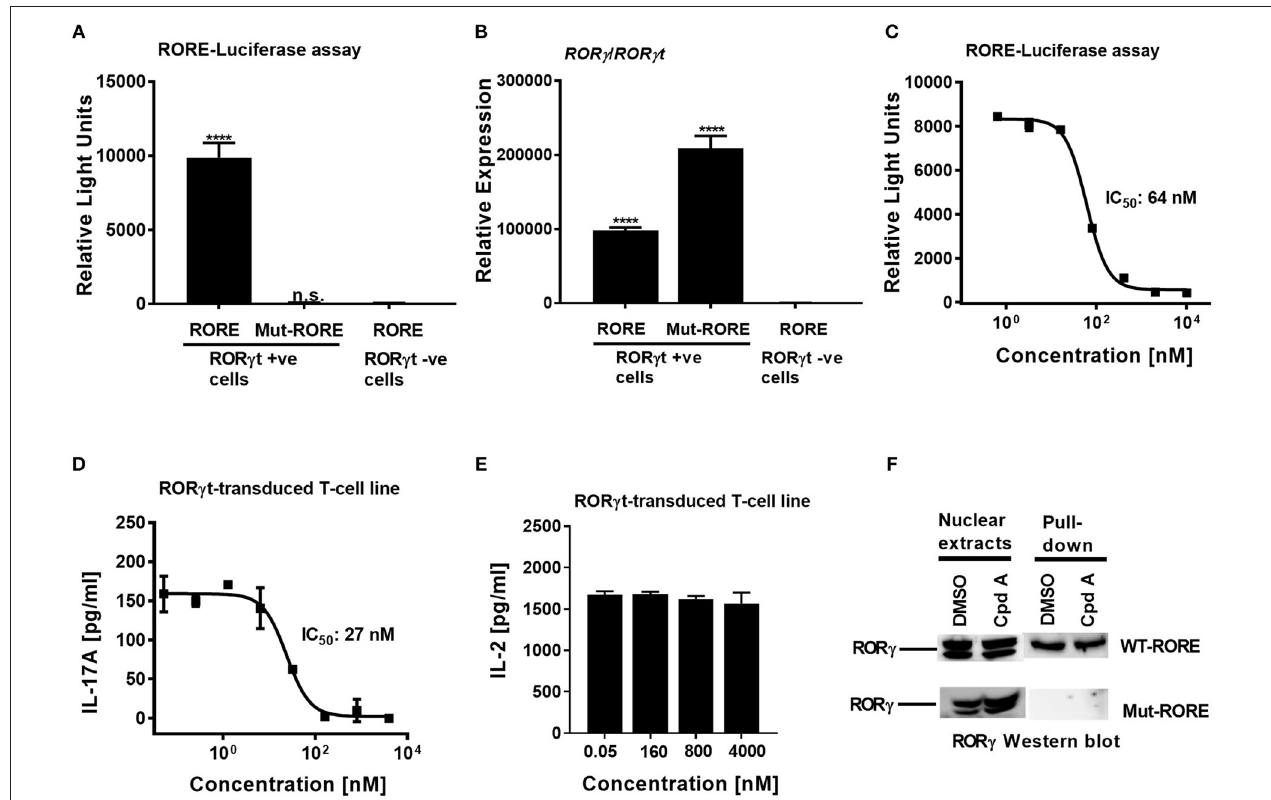
FIGURE 2 | Cpd A potently inhibits transcriptional activity of human ROR γ t in the full-length context in T-cells. (A) Full-length ROR γ t drives wild-type RORE-dependent activation of a reporter gene in HUT78 T-cells expressing ROR γ t, but not in ROR γ t negative cells. HUT78 cells stably expressing ROR γ t or empty control vector were transfected with 4 x RORE or mutated RORE-luciferase reporter constructs, followed by stimulation with CD3 antibody/PMA for 48h and by quantifying luciferase activity. (B) Gene expression level of ROR γ / ROR γ t in HUT78 T-cells stably expressing ROR γ t or control vector together with RORE or mutated RORE-reporter genes. (C) Cpd A potently blocked RORE-mediated transcription of the luciferase reporter gene. HUT78 T-cells were stimulated with CD3 antibody plus PMA for 48h followed by measurement of luciferase activity. (D) HUT78 T-cells stably expressing ROR γ t were incubated with serial dilutions of Cpd A at the beginning of the stimulation with PMA and anti-CD3 antibody and after 48h IL-17A or IL-2 (E) concentrations were measured by ELISA. Representative examples of concentration-response curves from three independent experiments are shown. The average IC 50 value obtained for SR2211 in the ROR γ t-IL-17A inhibition assay was 257 ± 181nM ( n = 2). (F) ROR γ t transduced HUT78 T-cells were pre-incubated with Cpd A (10 µ M) or DMSO, followed by a 2h stimulation with anti-CD3 antibody/PMA and nuclear extracts were prepared. Nuclear extracts were subjected to pull-down experiments using mutated (Mut-ROREs) or wild-type (WT ROREs) biotinylated RORE oligonucleotides followed by immobilization of complexes with streptavidin Sepharose beads. Nuclear extracts (left panel) and RORE pull-down complexes (right panel) were subjected to SDS PAGE followed by ROR γ Western blot analysis. Results shown are representative of three experiments with triplicate readings with similar results, except for (B) which originates from a single experiment. Error bars show the SD. Statistical analyses were performed using one way ANOVA Dunnett’s test, **** p < 0.0001.